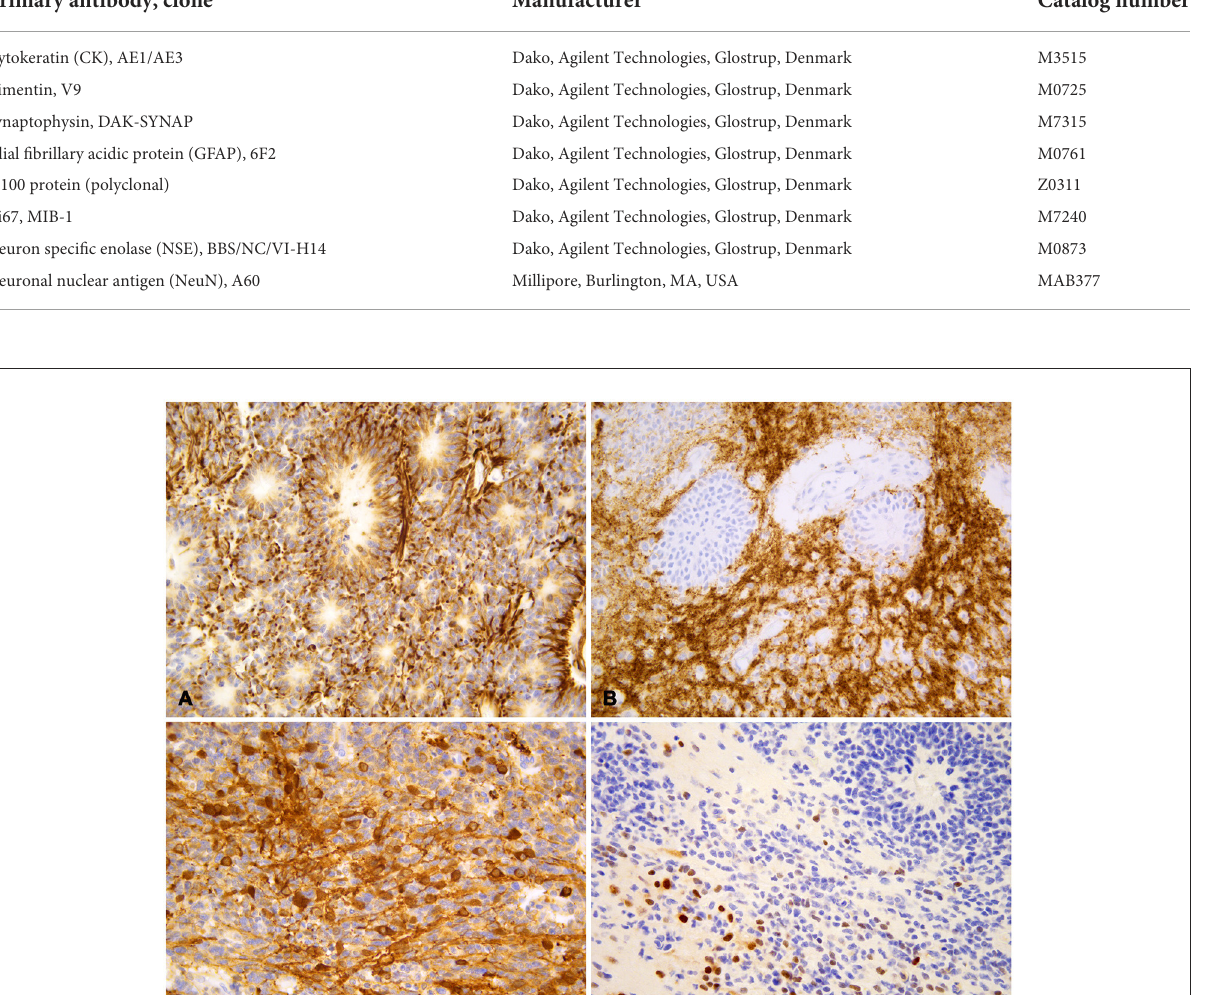
TABLE 1 List of primary antibodies tested on the feline embryonal tumor with multilayered rosettes, with manufacturers and catalog numbers. Primary antibody, clone